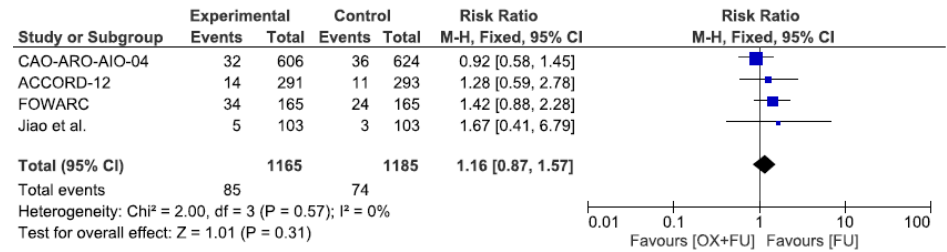
Figure 8. Forest plot of risk ratio for hematological toxicity.